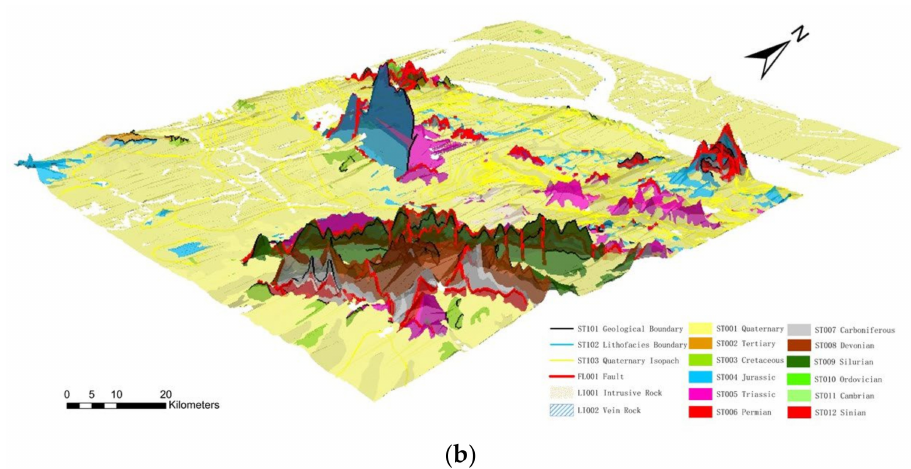
Figure 6. Graphic representation of the spatial structure RGSSML of the Ningzhen Mountain range (Nanjing